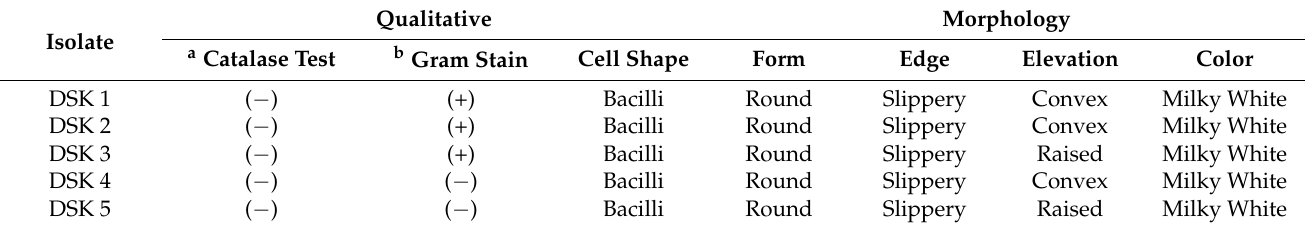
Table 1. Identification qualitative and morphology